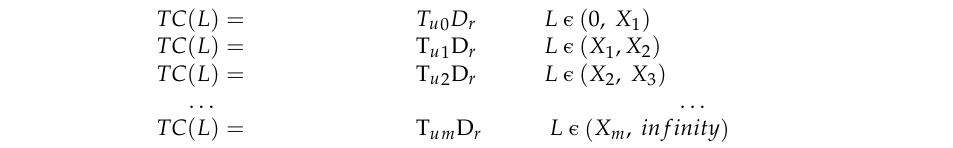
Table 3. Equation for transportation